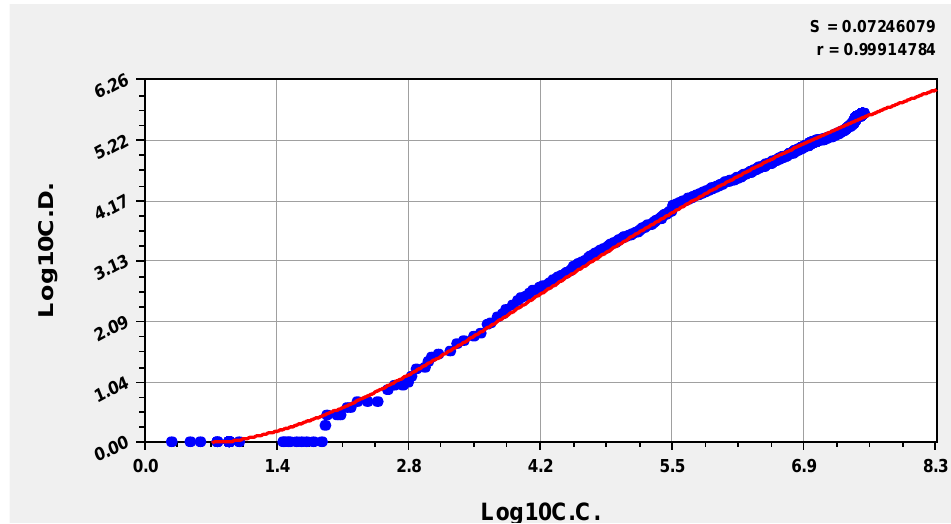
Figure 5. MMF best model fitting for both transformed cumulative mortality versus morbidity for Coronavirus disease